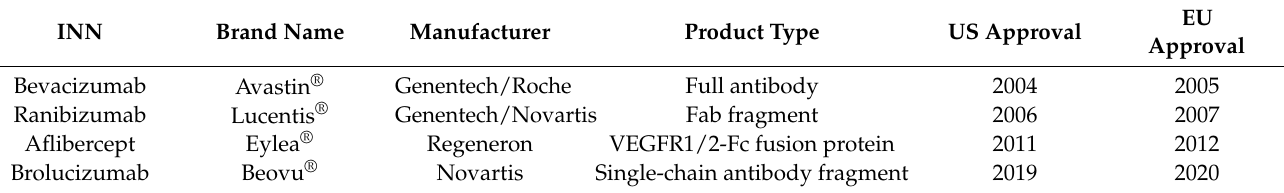
Table 1. Approved anti-VEGF biological medicines in the US and